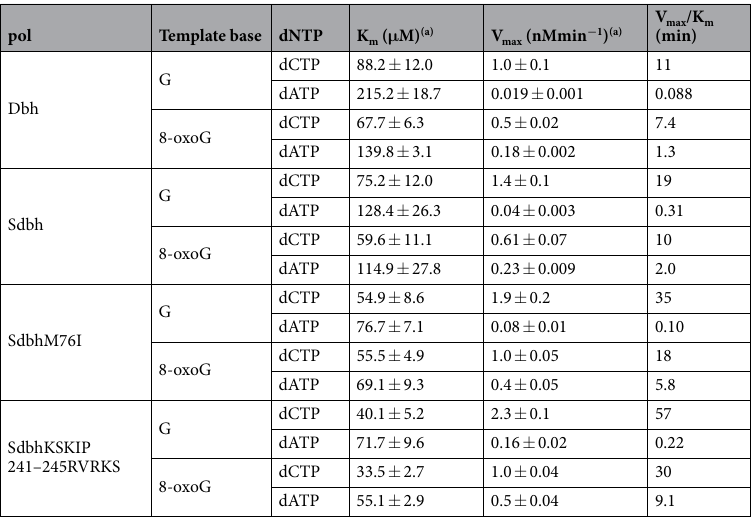
Table 3. Steady-state kinetics of incorporation of dCTP and dATP opposite G and 8-oxoG bases by Dbh and the variants. (a) The values of V max and K m were fit by nonlinear regression of the Michaelis-Menten equation. All reactions were done in duplicate, and the indicated data points are shown as the mean ± standard